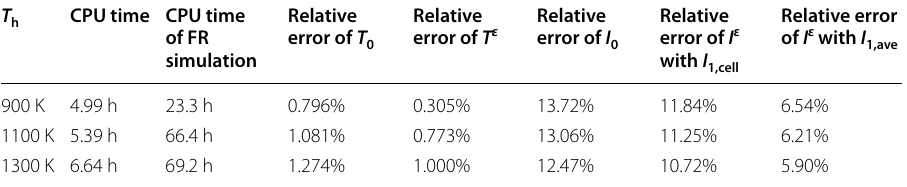
Table 3 Results of the multiscale simulations with different boundary temperature T fully‑resolved)